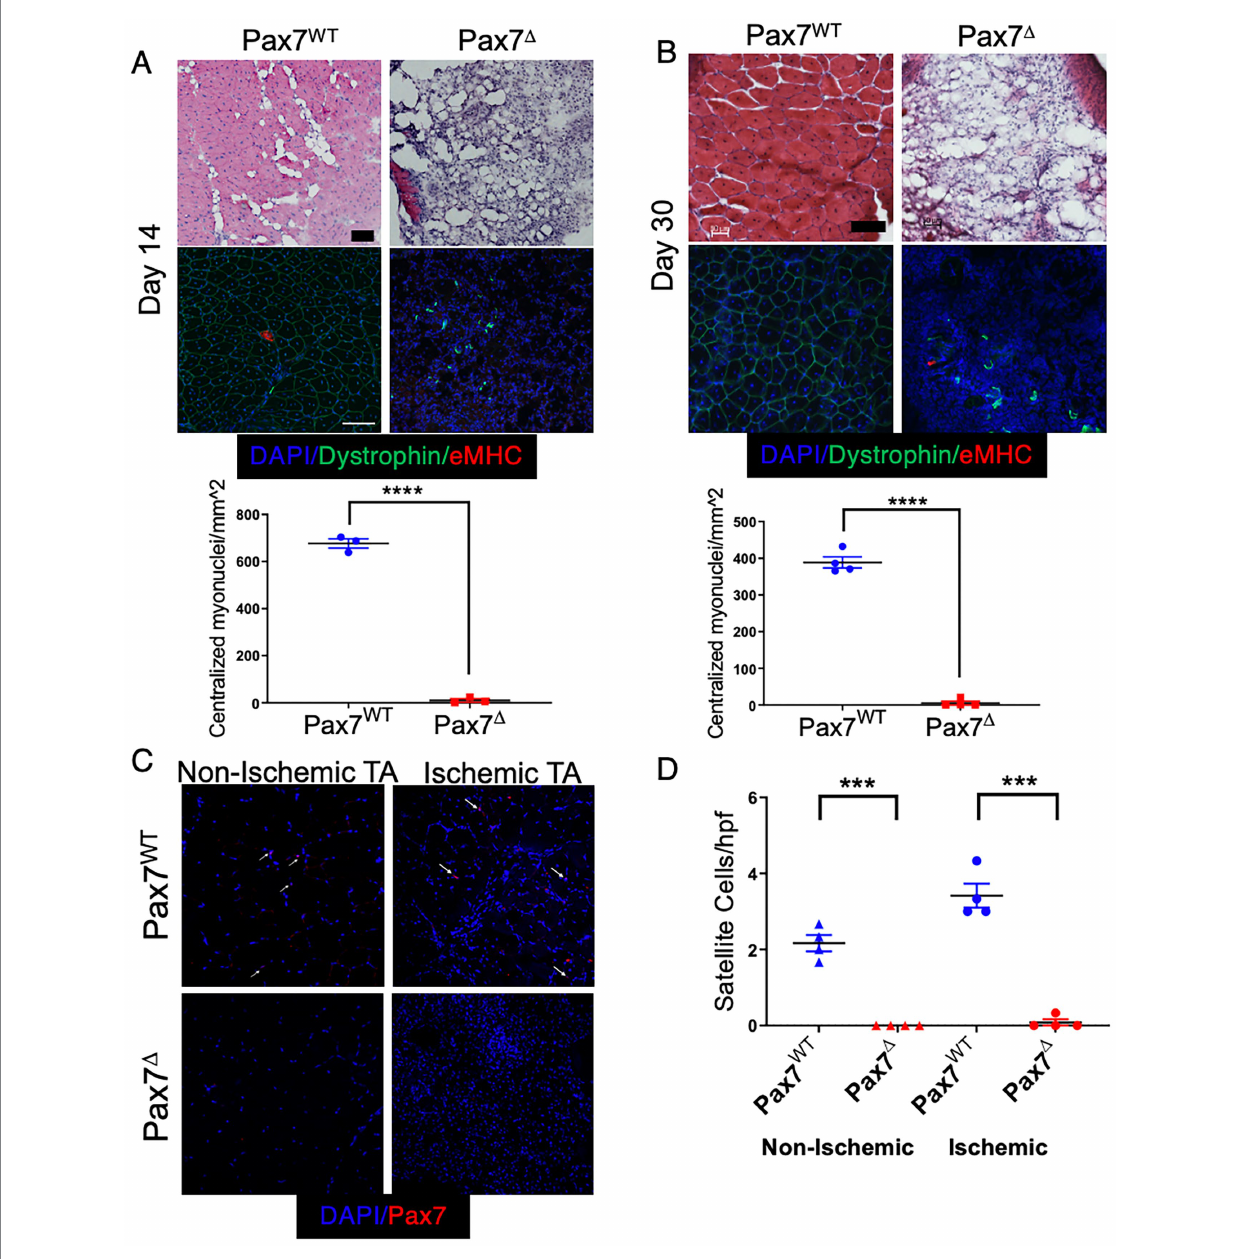
FIGURE 3 Sustained deletion of satellite cells results in long-term prevention of muscle regeneration after HLI. (A,B) H&E staining and quantification of regenerating fibers, demonstrated by myofibers with centralized myonuclei, of the ischemic TA muscle at 14 days (A) and 30 days (B) after ischemia demonstrated a complete lack of regeneration ( n = 3–4 per group). (C,D) 30 days after HLI Pax7 + cells per high power field were significantly increased (2-fold) in the ischemic relative to the non-ischemic TA muscle of Pax7 WT mice, although their numbers were diminished compared to 7 days post-HLI. Pax7 + cells were persistently absent in Pax7 Δ mice ( n = 4 per group). Scale bar = 100 μ m. All data shown are means +/ − SEM. *** p < 0.001, **** p < 0.0001 by 2-sided t